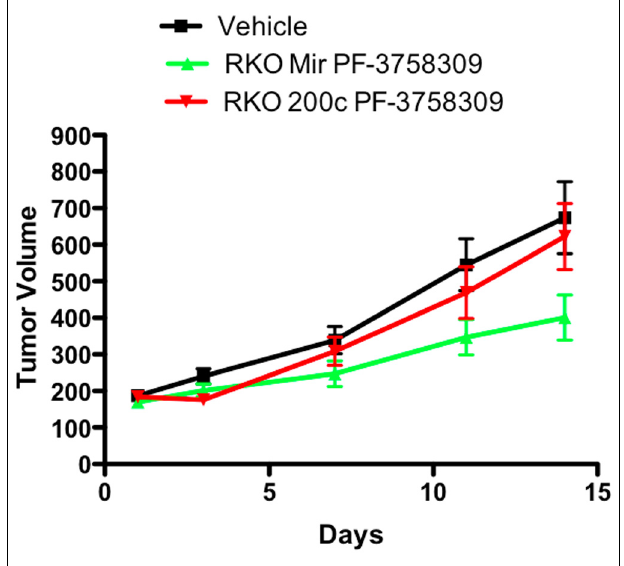
FIGURE 10 |Antiproliferative effects of an miRNA 200c transfected RKO cell line in a xenograft model.